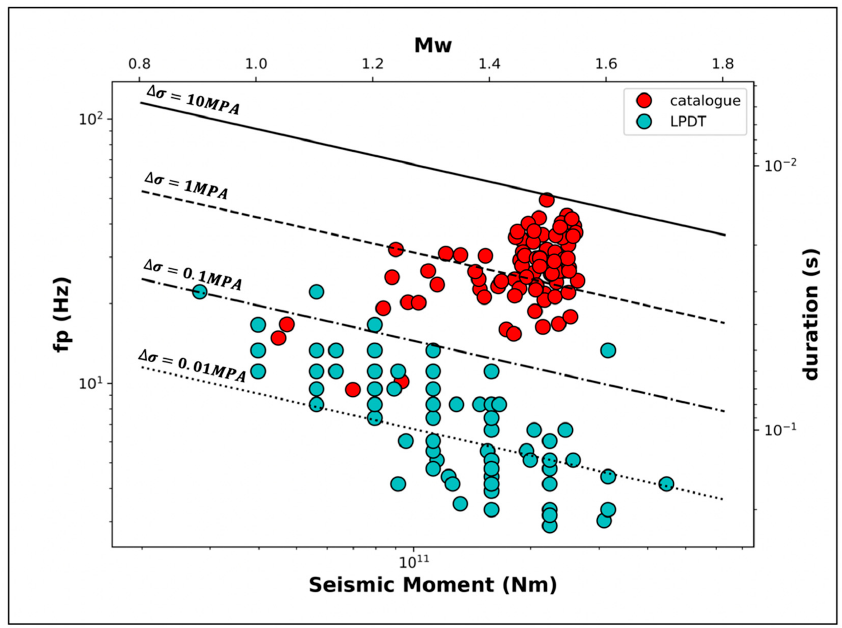
Figure 4. Representation of frequency and duration (left and right axis) versus moment magnitude and seismic moment (upper and lower axis). The cyan points are the parameters obtained with the LPDT method, while the red points are the parameters from the refined catalogue of Kwiatek et al. [27]. Different values of stress drop are shown on the graph. It is visible that data from the LPDT method follow a better constant stress drop scaling.